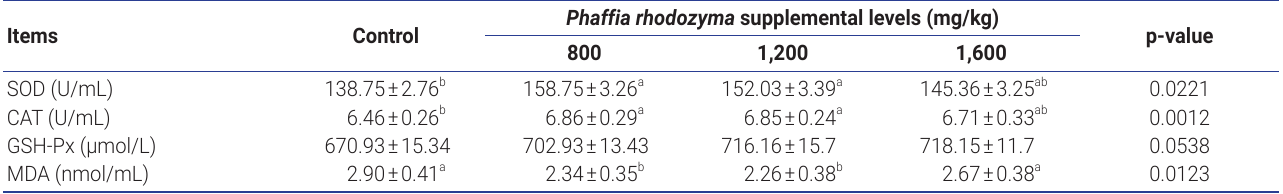
Table 4. Effect of dietary astaxanthin rich Phaffia rhodozyma levels on antioxidant defenses of laying hens Items